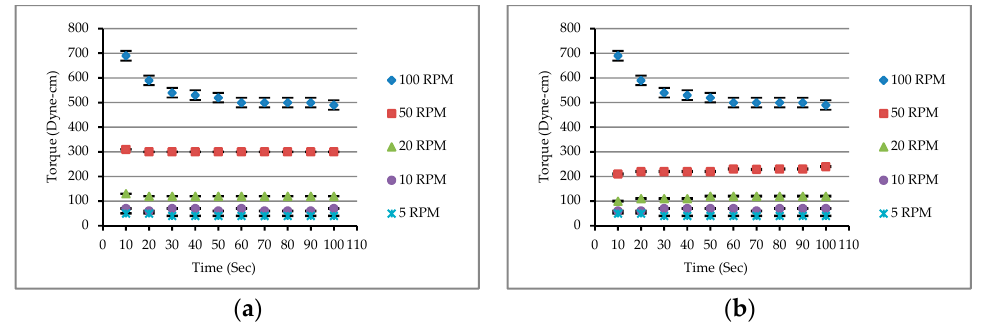
Figure 1. The relationship between torque and time of matrix (M13): ( a ) the spindle’s rotational speed under acceleration conditions; ( b ) the spindle’s rotational speed under deceleration conditions.